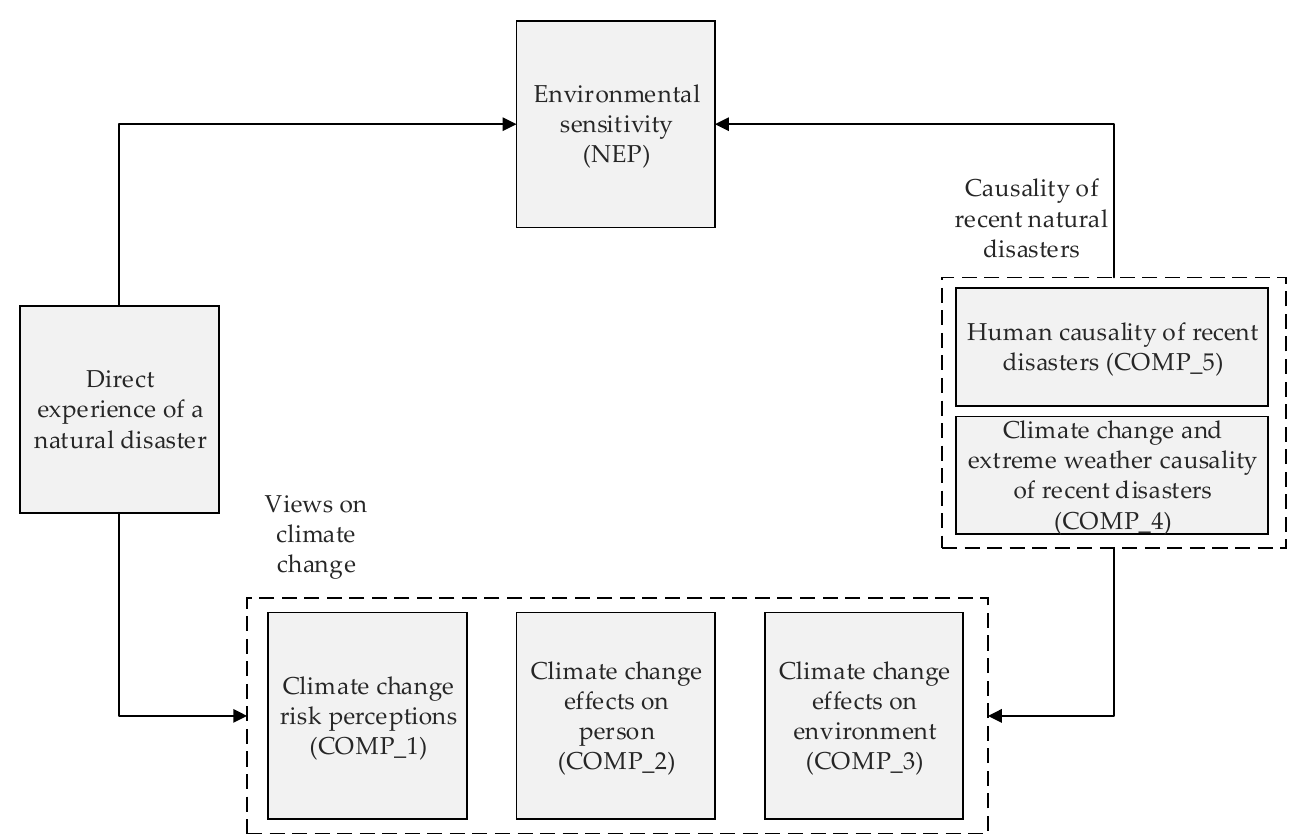
Figure 4. Summary of results showing main associations between the examined parameters.